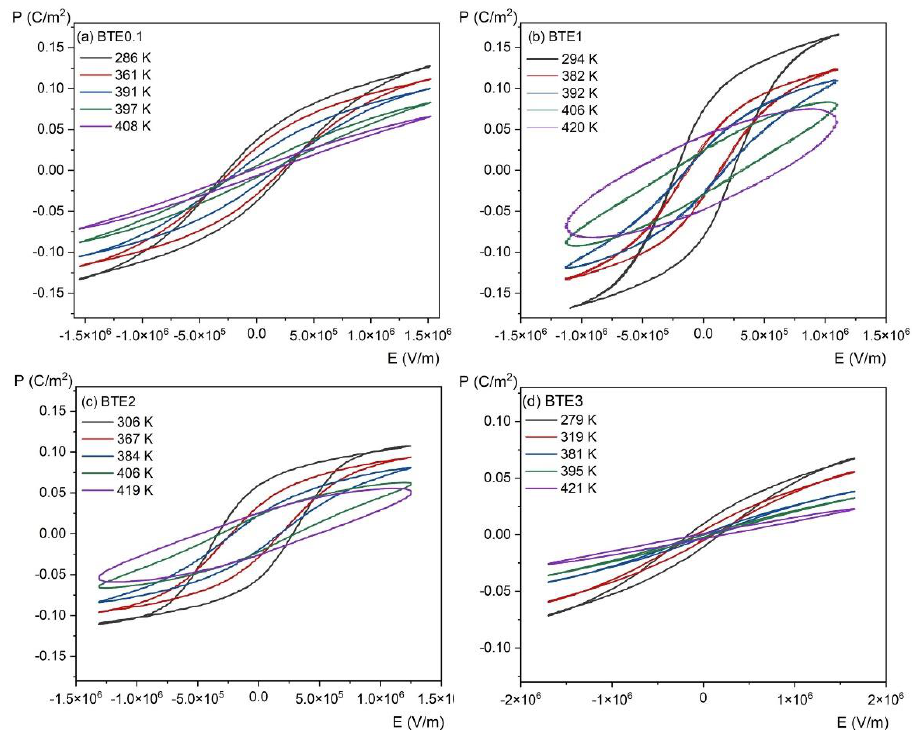
Figure 10. Temperature-dependent P ( E ) hysteresis loops of BTEx ceramics: ( a ) BET0.1, ( b ) BTE1, ( c ) BTE2, and ( d ) BTE3.